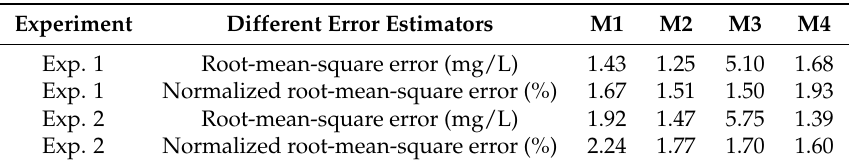
Figure 11. Section of 21 days suspended particulate inorganic matter (SPIM) from out-of-learning phase for Exp. 1 in ( a ) and Exp. 2 in ( b ), surface SPIM (Exp. 1, Exp. 2 and SPIM _ sat ) in ( c ), resultant barotropic velocity in ( d ) and significant wave height ( Hs ) in ( e ) at station M3. Table 3. The error estimated for the entire section (15 months temporally and 11 depth levels) of learning phase for four